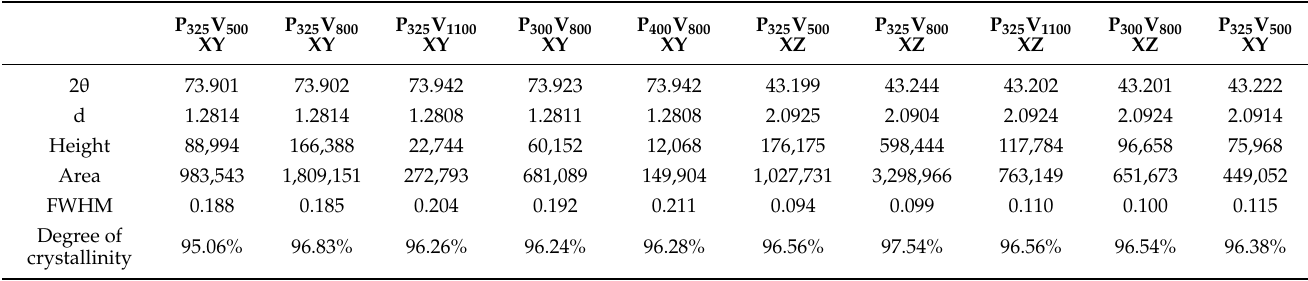
Figure 6. The XRD patterns of XY planes ( a ) and XZ planes ( b ) of Cu–Cr–Nb–Ti alloy manufactured using different process parameters. Table 3. The XRD analysis results of Cu–Cr–Nb–Ti alloy manufactured using di ff erent process parameters.